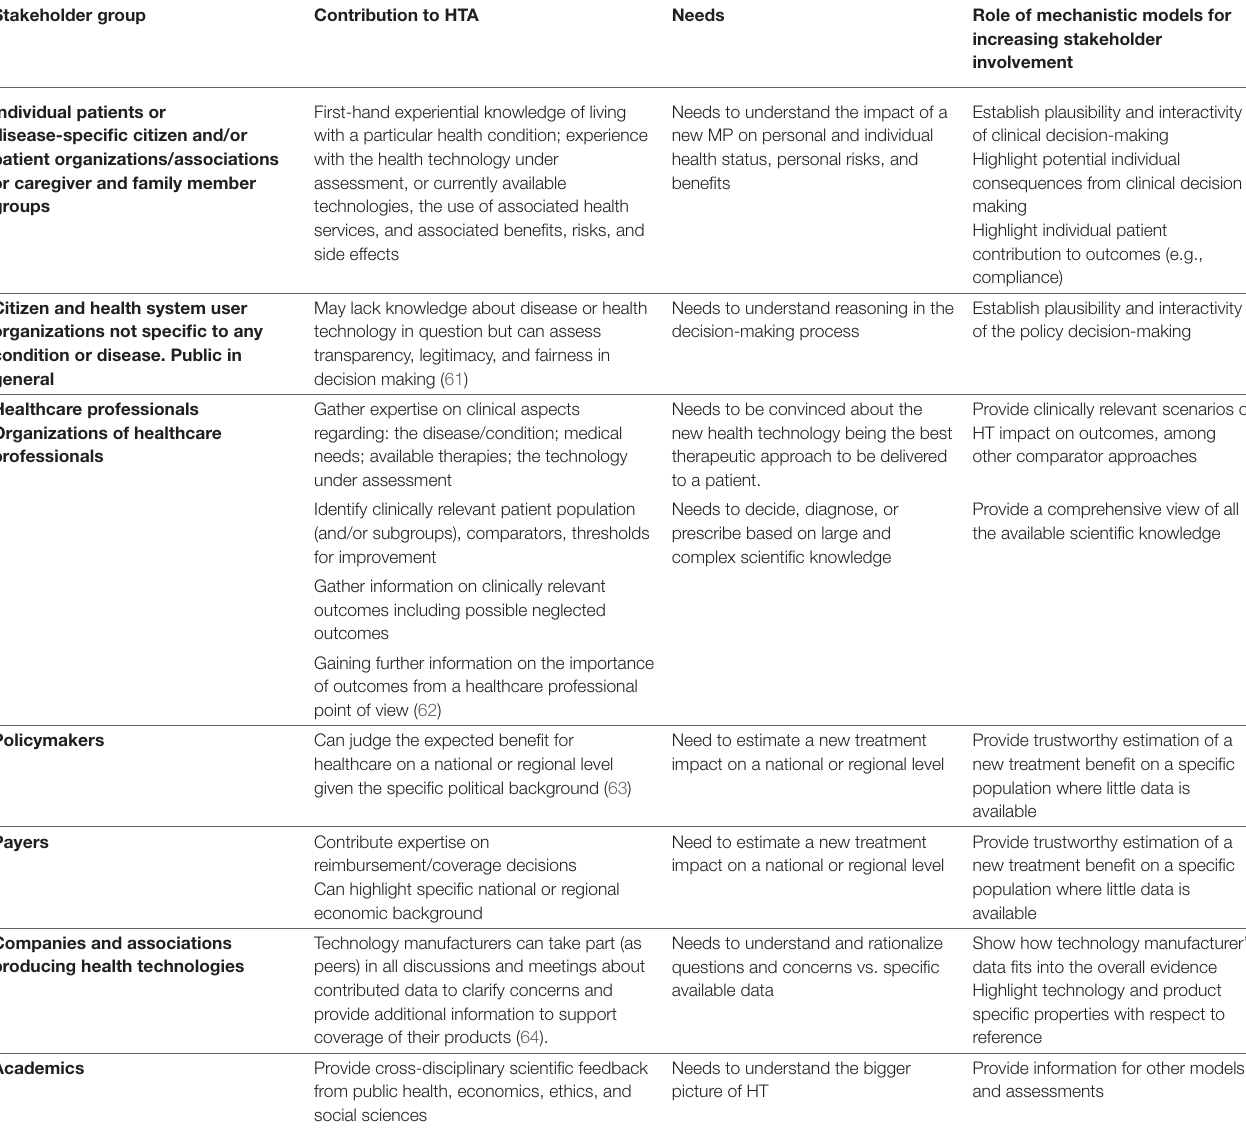
TABLE 2 | List of different Stakeholder groups increasingly involved in the appraisal stage of HTA with dedicated contribution, special needs (to understand and capture a drug’s mechanism, effect, role, or impact) and example of how mechanistic modeling can help to address this need and fill persistent gaps. Stakeholder